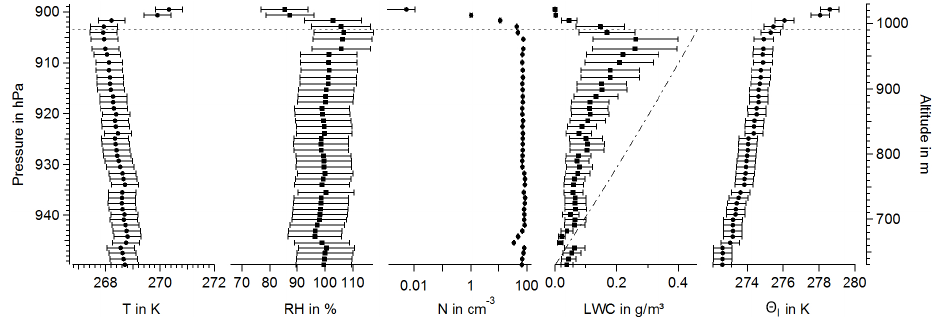
Figure 2. Altitude profiles inside the cloud encountered during Flight 11 (20:05–20:25UTC) on 15 May 2012. Gradients of temperature T and the relative humidity RH above 990m indicate that the cloud is capped by a warmer and drier atmosphere. The droplet number concentration N is constant inside the cloud. LWC and the liquid water potential temperature (cid:50) l show an increase with altitude. The adiabatic LWC is indicated by the dash-dotted line. The horizontal dashed line marks the beginning of the cloud top transition zone at an altitude of 990m. The error bars for T and RH result from the uncertainty of the instruments and the errors for N are very small and based on counting statistics. For LWC and (cid:50) l the error is calculated by error propagation from the measured parameters. 119 km in total